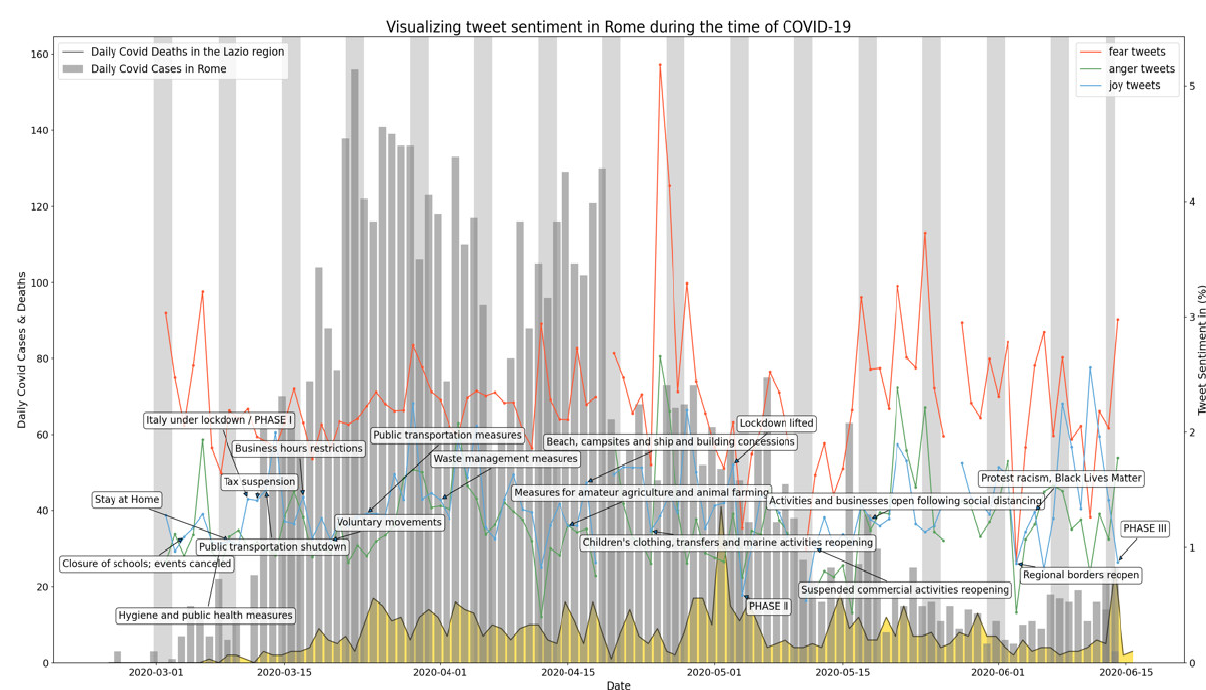
Figure A6. Visualizing Twitter sentiment in Rome during the time of COVID-19.